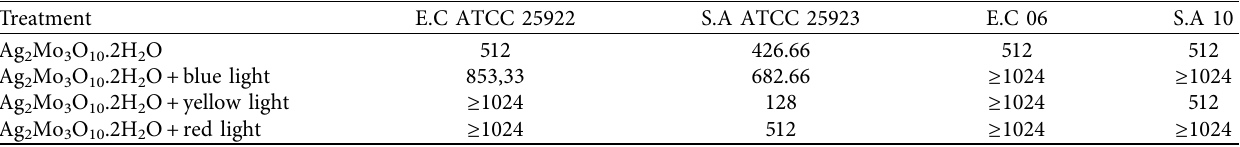
Table 1: Minimum inhibitory concentration (MIC) of Ag